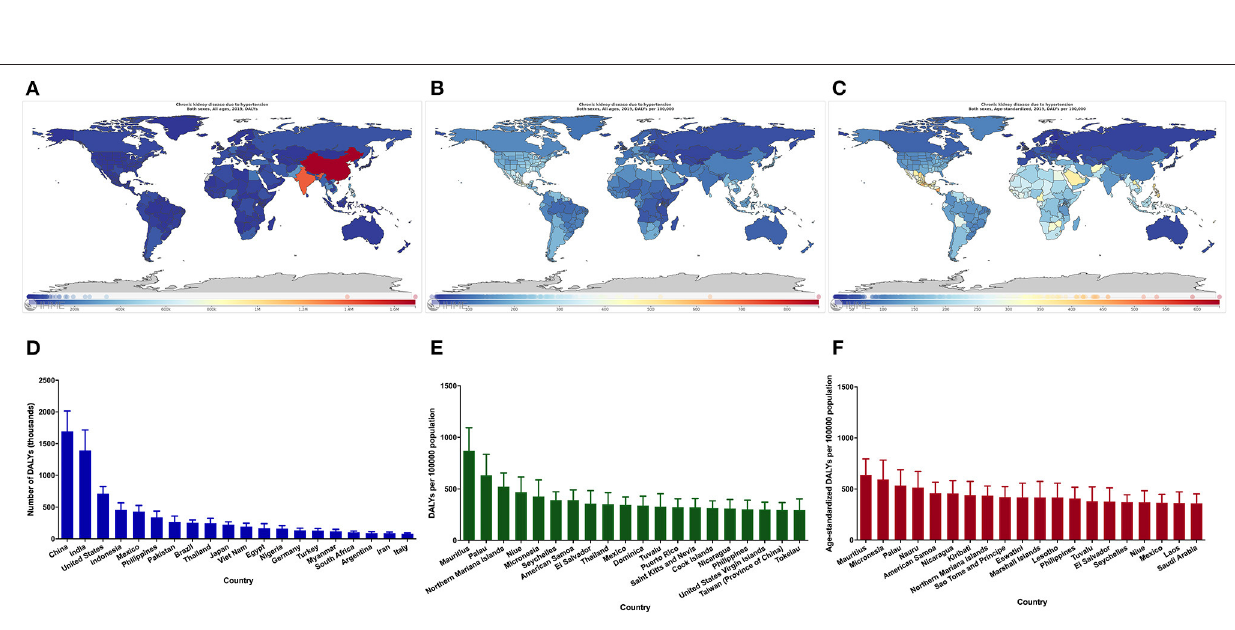
Frontiers in Medicine | www.frontiersin.org